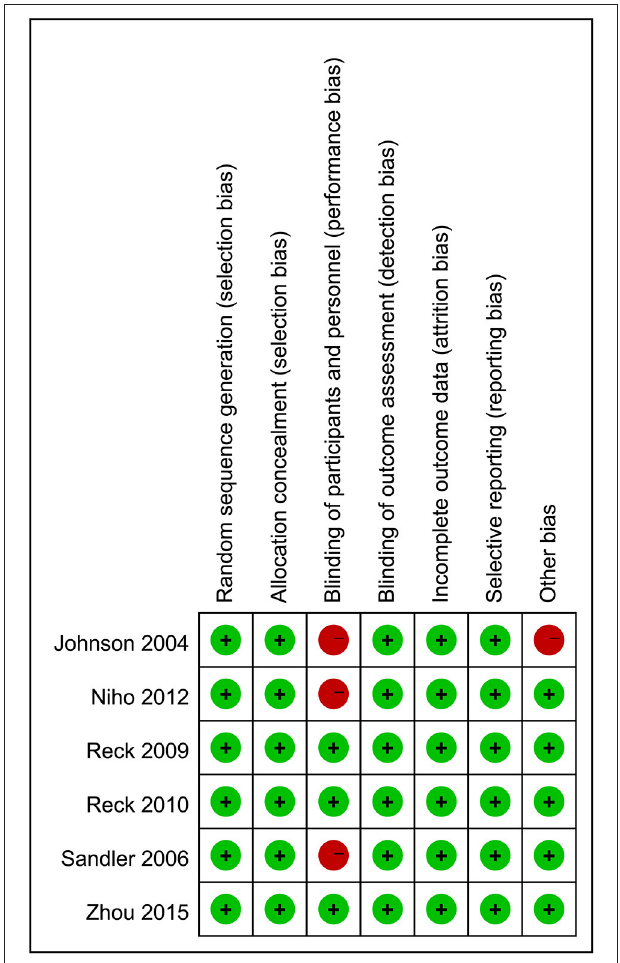
FIGURE 2 | Risk of bias summary. + = low risk of bias; - = high risk of bias; ? = unclear risk of bias.